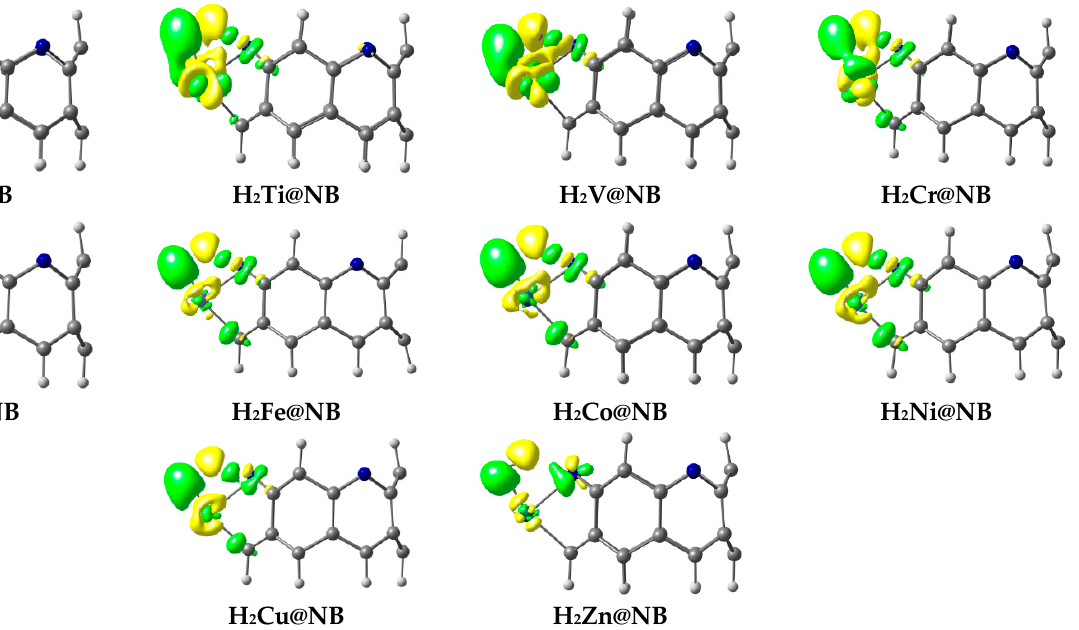
Figure 7. EDD analysis of hydrogen-adsorbed TM@NB complexes; green color is for electron density accumulation, whereas yellow color is for depletion of electronic density. Table 4. Comparison of hydrogen dissociation barrier over Sc@NB catalyst with already reported barriers over various